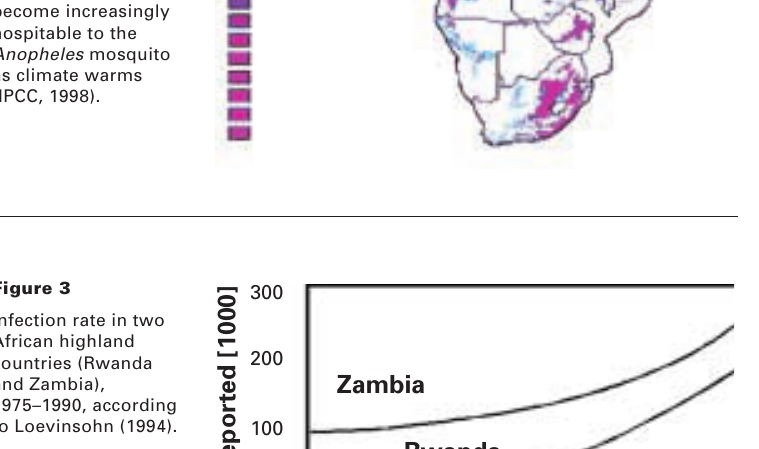
Changes in the inci- dence rate of malaria in Africa, following a modest 1 °C average temperature in- crease. Grey scale denotes the advance of the vector into re- gions currently malaria-free. These are essentially the African highland re- gions above 1000 m; note that the spread